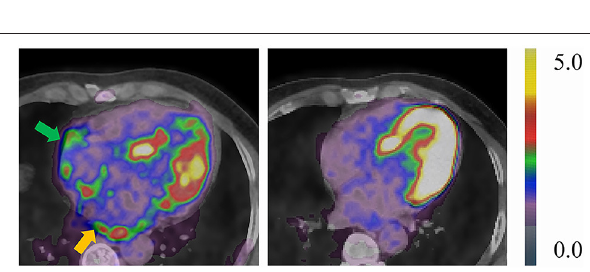
FIGURE 3 | Representative case of a 49-year-old male PsAF patient before (left: TBR LA = 2.16, TBR RA = 1.79) and after RFCA (right: TBR LA = 0.69, TBR RA = 1.36). Yellow arrow indicates abnormal LA FDG uptake, green arrow indicates abnormal RA FDG uptake. Both LA and RA FDG activities reduced compared to baseline